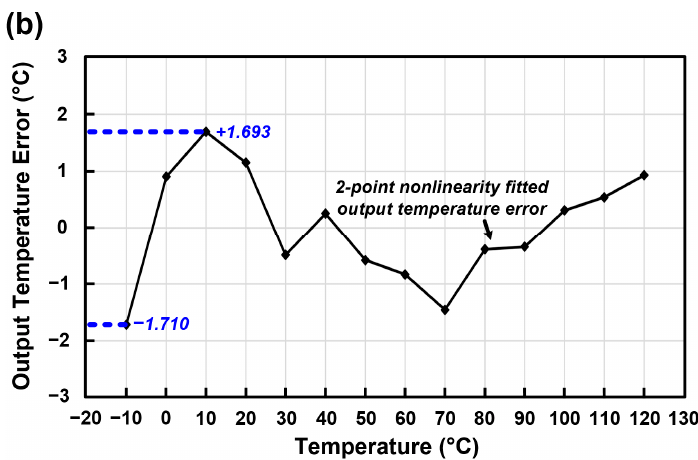
Figure 15. Measured output data of the temperature sensor of the proposed sensor analog front-end. ( a ) Measured output temperature data; ( b ) Error of the two-point nonlinearity fitted output